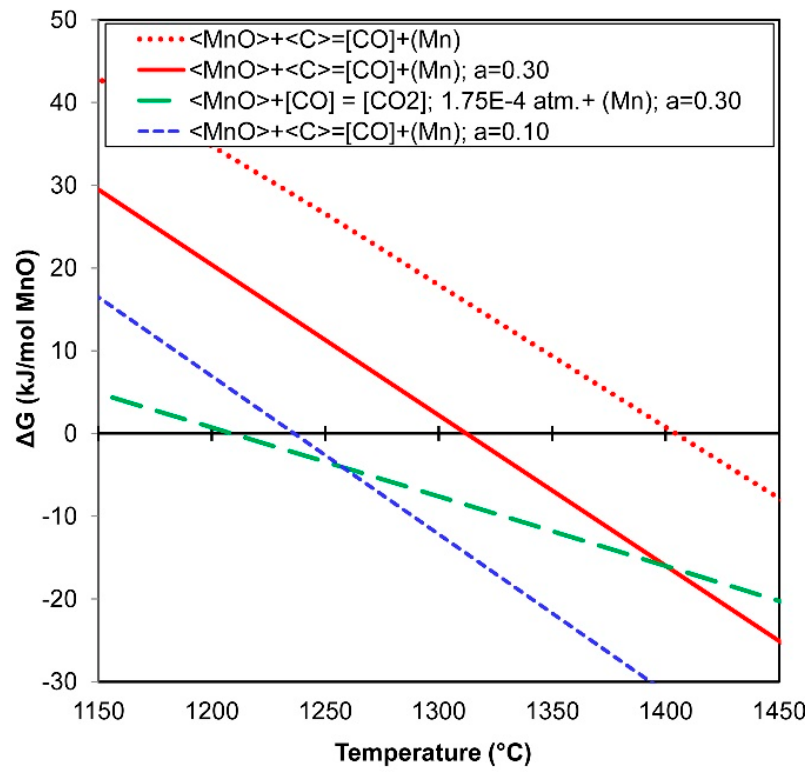
Figure 16. Reaction of Gibbs energy: effect of a Mn(l). Reaction (1) is only possible at unit activities of Mn, C, and 1 atm P CO , at temperatures above 1407 ◦ C, as indicated by the dotted red line in Figure 16. Lowering of the activity of Mn in reaction (1) reduces the minimum required temperature for MnO reduction to 1312 ◦ C at a Mn = 0.30 and 1236 ◦ C at a Mn = 0.10, see the solid red line and dotted blue line in Figure 16. To lower the minimum required temperature for reaction (1) to 1200 ◦ C requires the gas-phase reduction reaction to be considered, reaction (3). When the CO partial pressure is maintained at 1 atm, and the CO 2 partial pressure is lowered substantially by the Boudouard reaction, reaction (2), for illustration purposes selected here as 1.75 × 10 − 4 atm from the Boudouard reaction equilibrium at 1400 ◦ C, then the minimum required temperature for MnO reduction by CO gas is 1208 ◦ C, as shown by the green dashed line in Figure 16. Although the Boudouard reaction equilibrium CO 2 partial pressure at 1200 ◦ C is higher (2.02 × 10 − 3 atm) than at 1400 ◦ C, the CO 2 partial pressure must be lowered to less than 1.75 × 10 − 4 atm at the MnO reduction reaction interface to drive the MnO